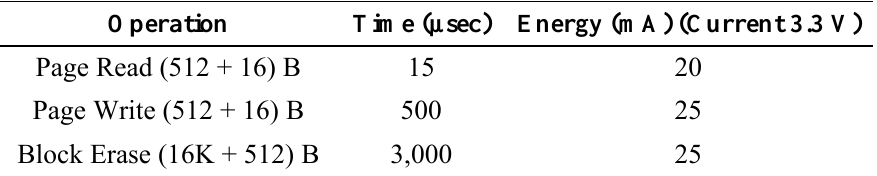
Table 2. Performance of NAND flash